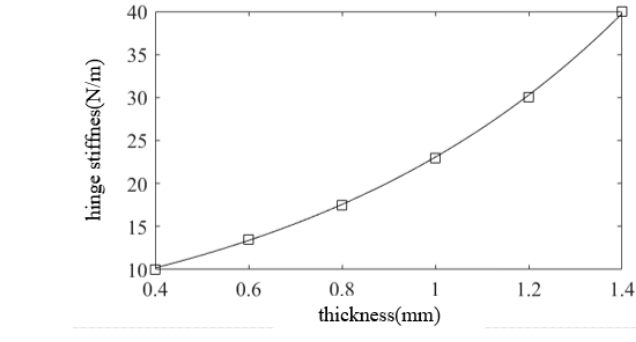
( b ) Figure 4. ( a ) Model of the flexure hinge tool holder; ( b ) first-order vibration mode. 2.2. Composite Control Algorithm To address the nonlinear effect of the piezoelectric actuator and the high-frequency phase delay of the FTS system, a composite control algorithm, as shown in Figure 5, was proposed. First, a PID closed-loop control system based on the Prandtl–Ishlinskii inverse hysteresis model was designed to eliminate the hysteresis effect of the piezoelectric actu- ator. Then, aiming at the system phase delay, a zero-phase error controller, G z ( z − 1 ), was designed on the basis of the closed-loop system, G c ( z − 1 ), to reduce the tracking error of the FTS system at high frequencies. Figure 5. Block diagram of the composite control algorithm.